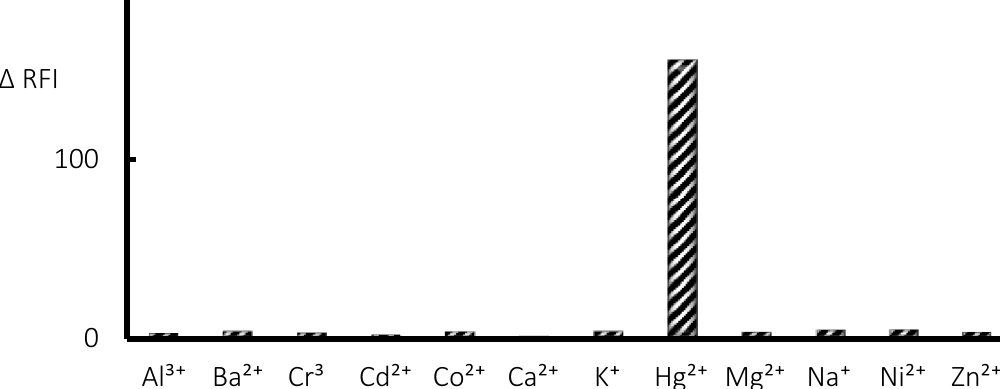
Figure 5. Examining the selectivity of the utilized system (OPD + H 2 O 2 + PVP-Ag-NPs) for the detection of Hg 2+ ion (1 µM) in the presence of common metals ions (10 µM).